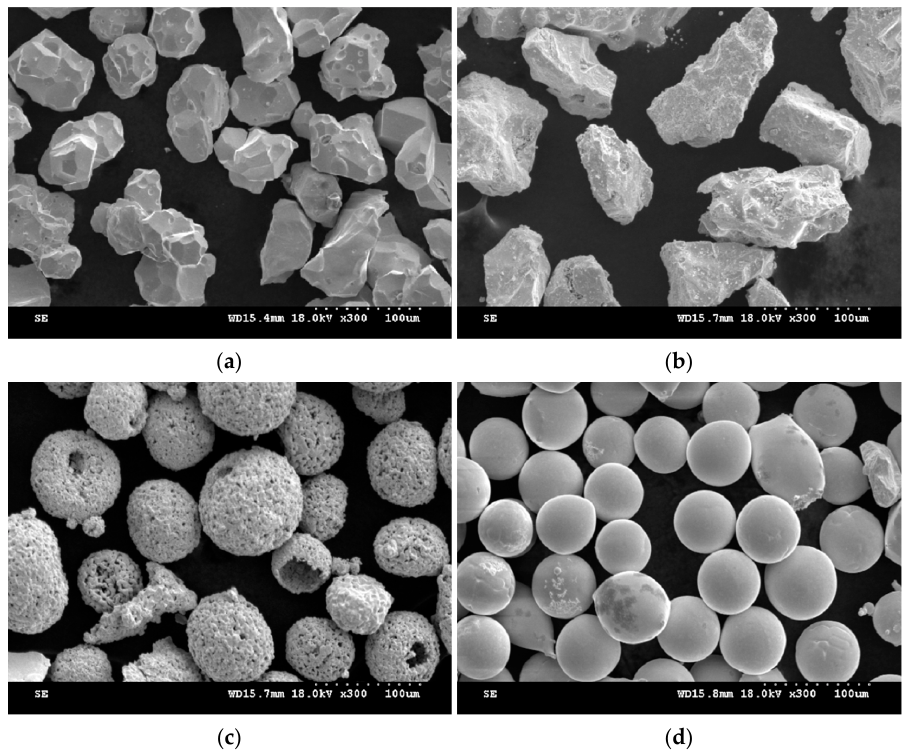
Figure 2. Scanning electron microscope (SEM) images of four metal powders. ( a ) Tungsten powders, ( b ) niobium powders, ( c ) molybdenum powders, ( d ) tantalum powders. Table 1. The basic physical parameters of the four materials used in the alloy. Metallic Element.